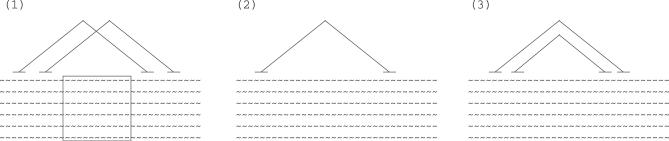
Sampling Alignment and StructureWe sample a new alignment by choosing a random window of the alignment that is devoid of base-pairs and by realigning it (step 1). We then sample a new RNA structure by removing a random set of helices from the given structure (step 2) and by adding a set of new helices (step 3).